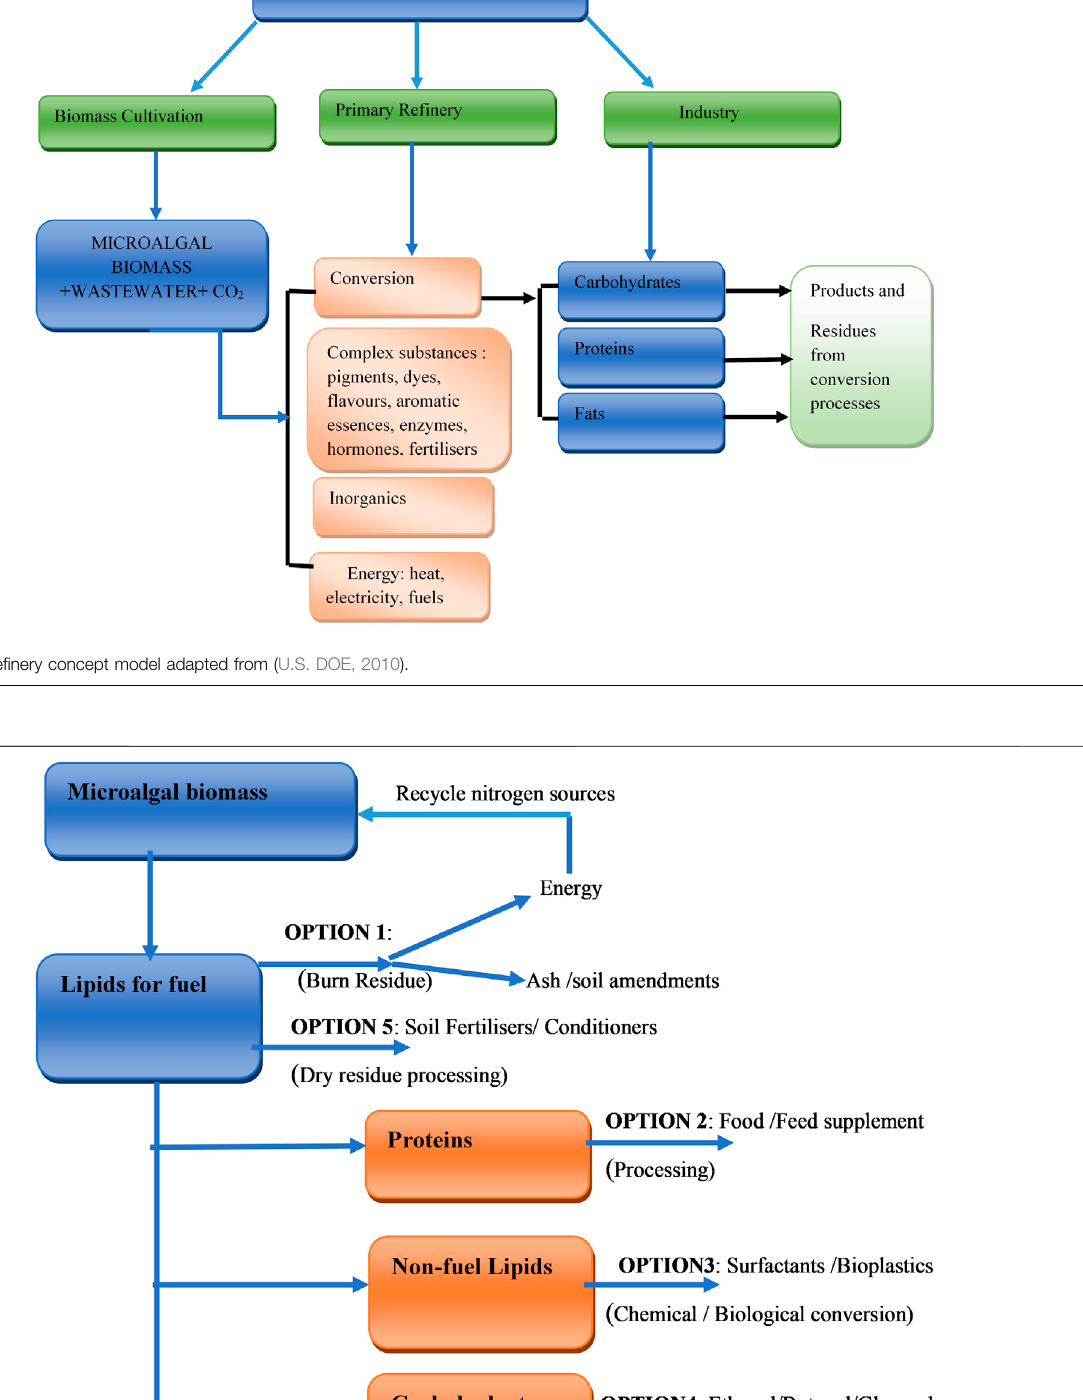
Frontiers in Energy Research |